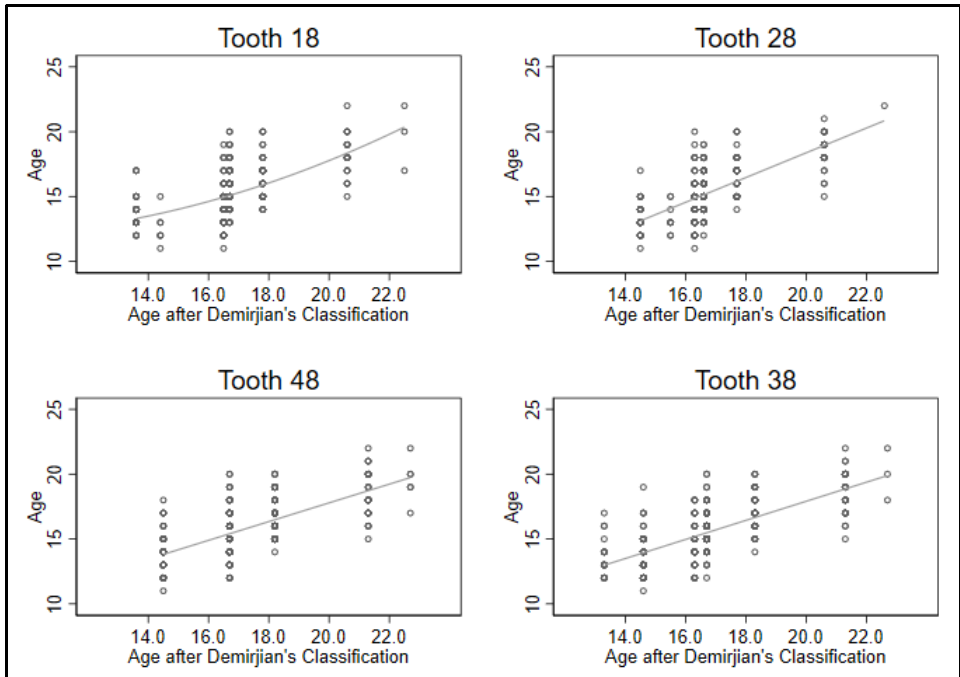
Figure 1. Observed and estimated values for age and tooth mineralization. Comparing the prediction of the four teeth individually revealed that the lower teeth gave better predictions than the upper ones (R 2 ≥ 0.50 vs. R 2 < 0.50, Table 2, last column). Particularly, tooth 18 performed poor (R 2 = 0.35). Comparing the regression coefficients showed similar values for teeth 18, 38 and 48 (beta ~ 0.72), tooth 28 has a steeper gradient of beta = 0.94. Standard errors are 0.06 for the upper teeth and 0.04 for the lower teeth. Constants are close to 3.3 for teeth 18, 38 and 48, -0.5 for tooth 28 (columns 1–3, Table